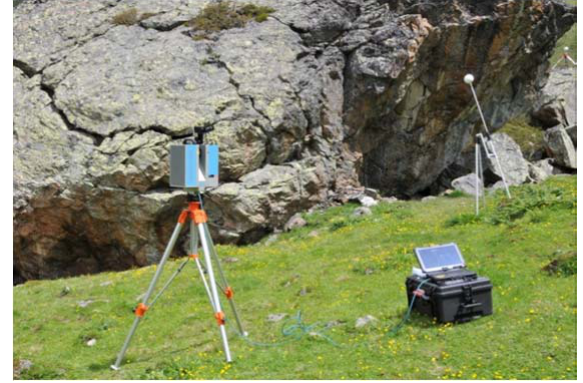
Figure 12: Scanning of the